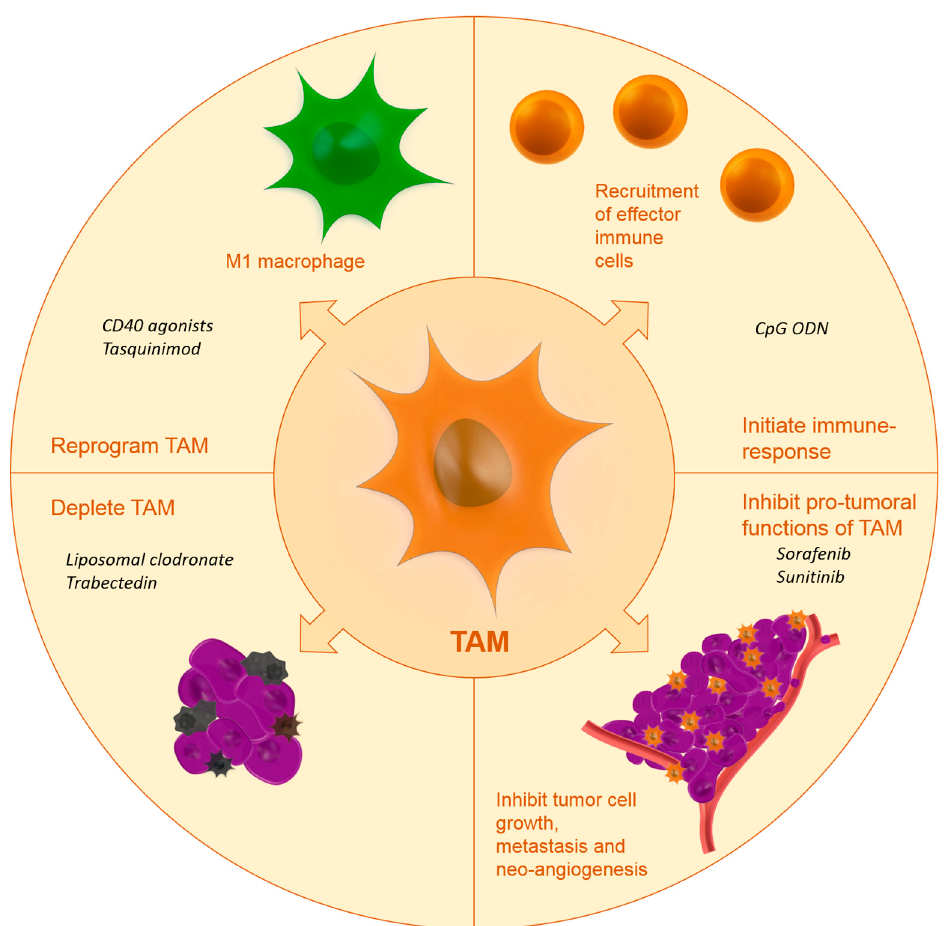
Figure 1. Anti-tumoral effects by targeting TAM using nanocarriers including examples of TAM-modulating therapies (in italics). Abbreviations: CD40: cluster of differentiation 40, CpG ODN: oligodeoxynucleotides containing CpG motifs